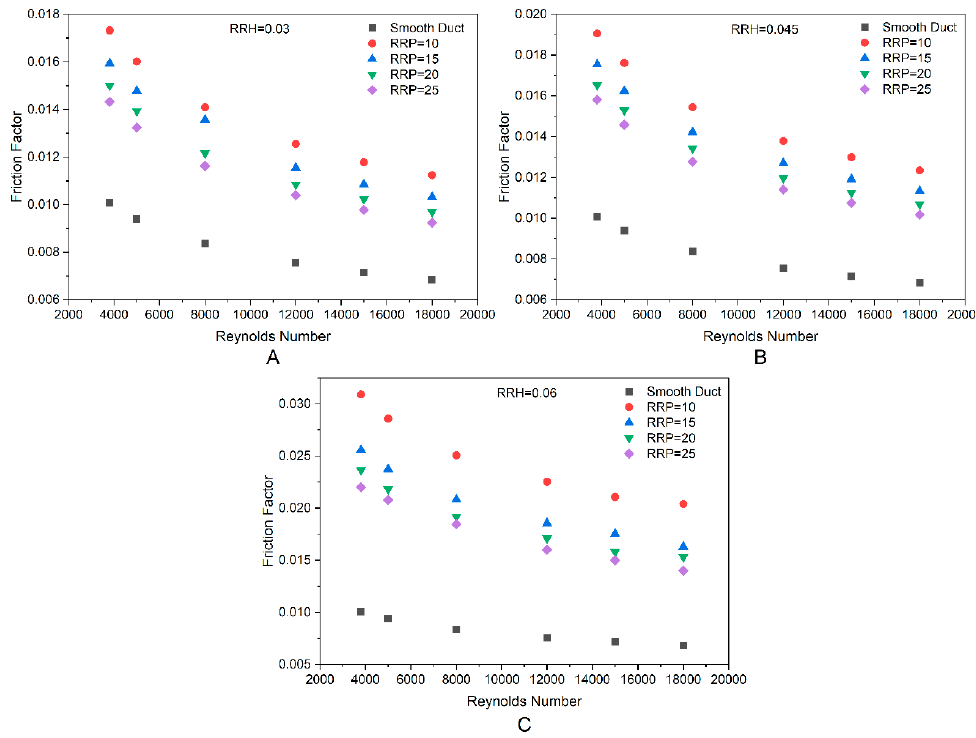
Figure 12. f r versus Re for ( A ) RRH = 0.03, ( B ) RRH = 0.045, and ( C ) RRH = 0.06.